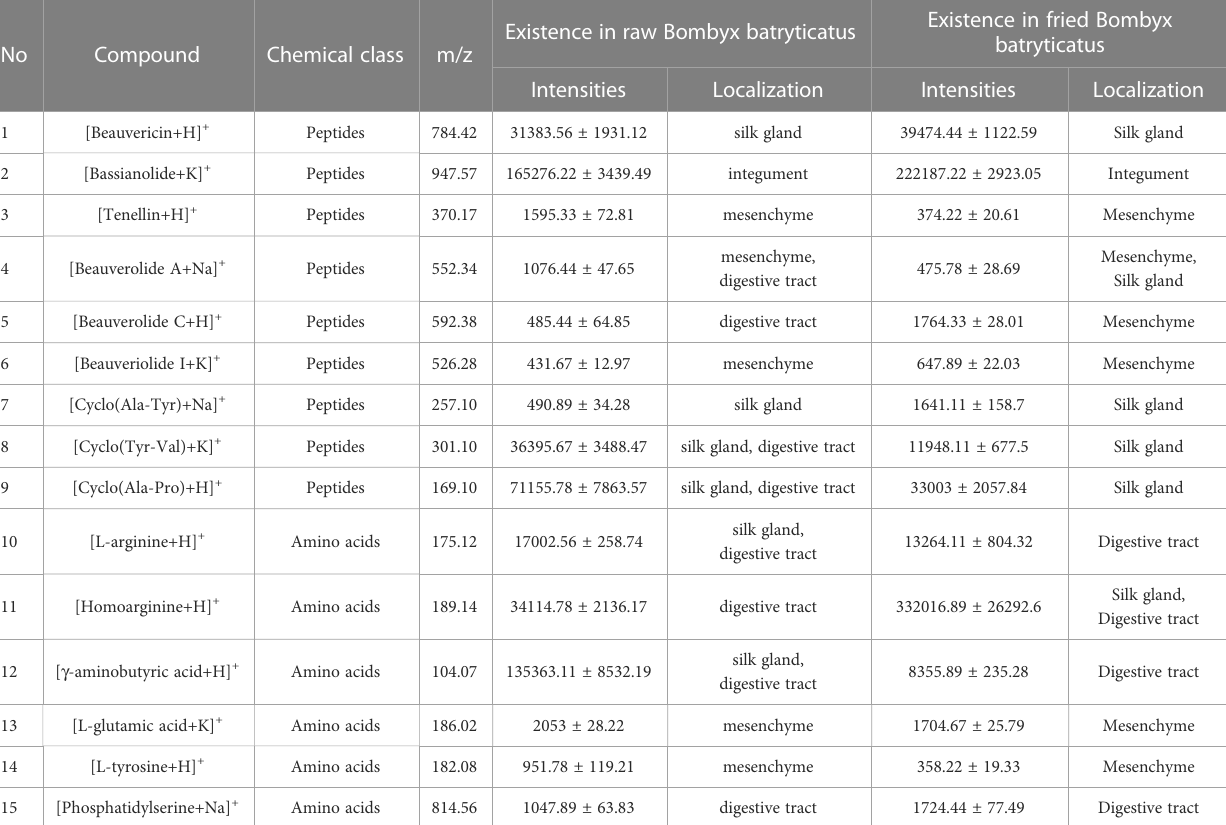
TABLE 2 Potential markers for the differentiation of raw Bombyx batryticatus and fried Bombyx batryticatus with their relative intensities and